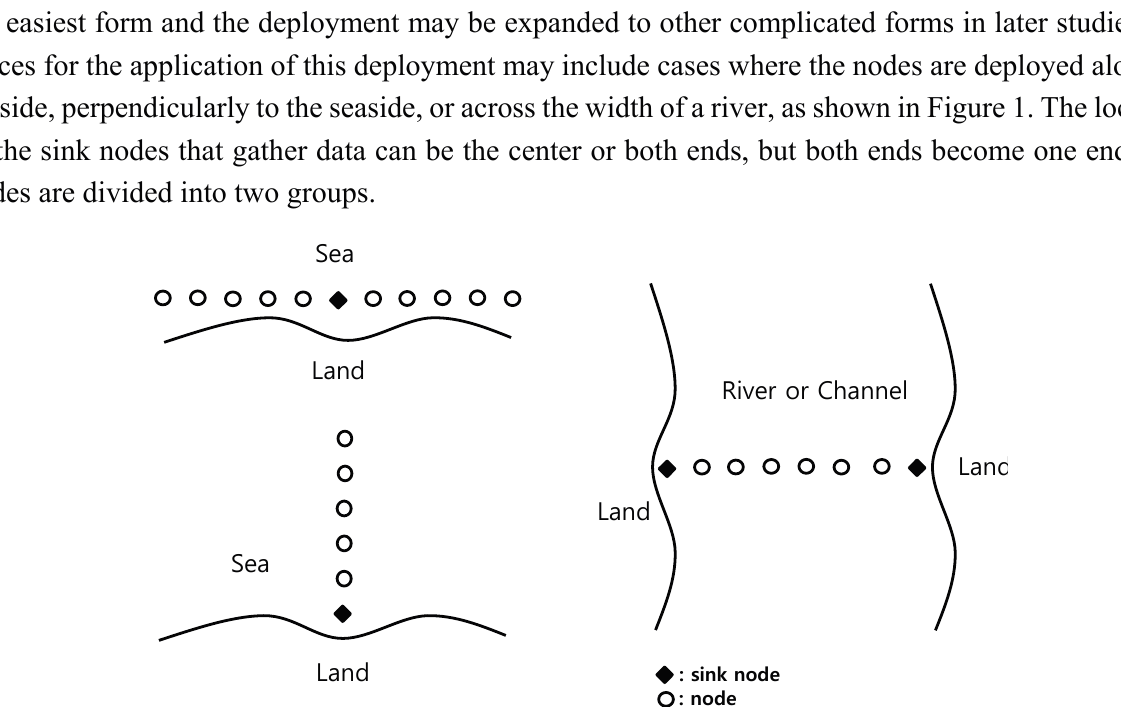
Figure 1. Place for the application of a one-dimensional linear sensor node